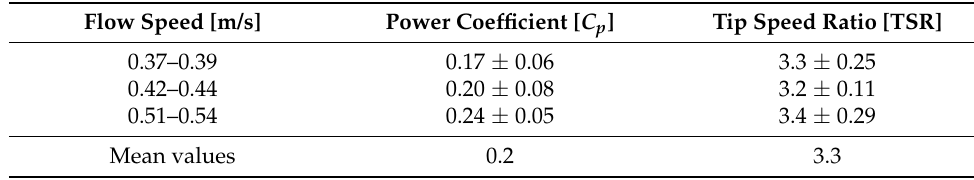
Table 3. Power coefficient and tip speed ratio mean values.